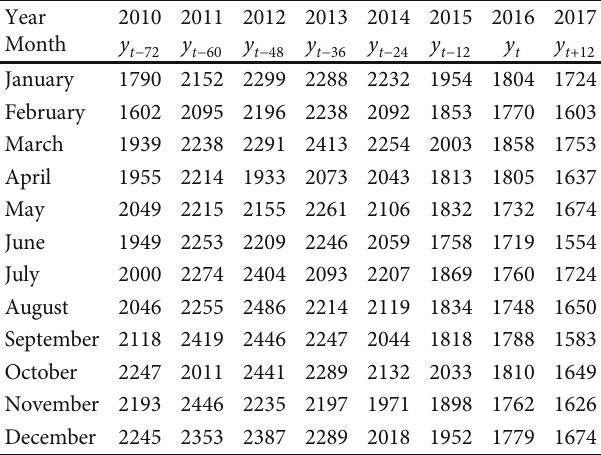
Table 1: Sample of input and output data of the neural